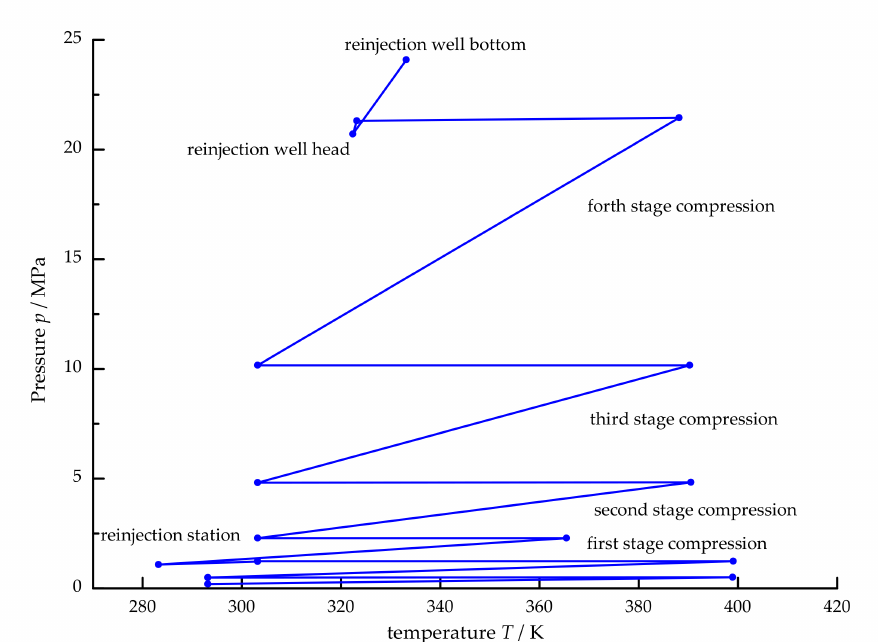
Figure 1. Temperature and pressure change during the proposed reinjection process of the fire- flooding